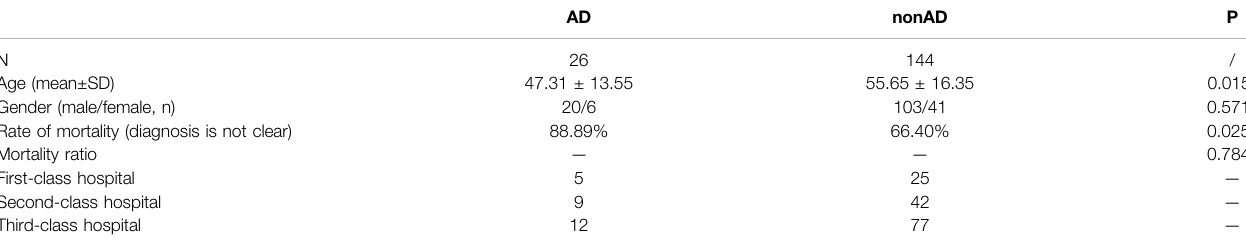
TABLE 4 | Clinical features of the medical dispute analysis subjects.